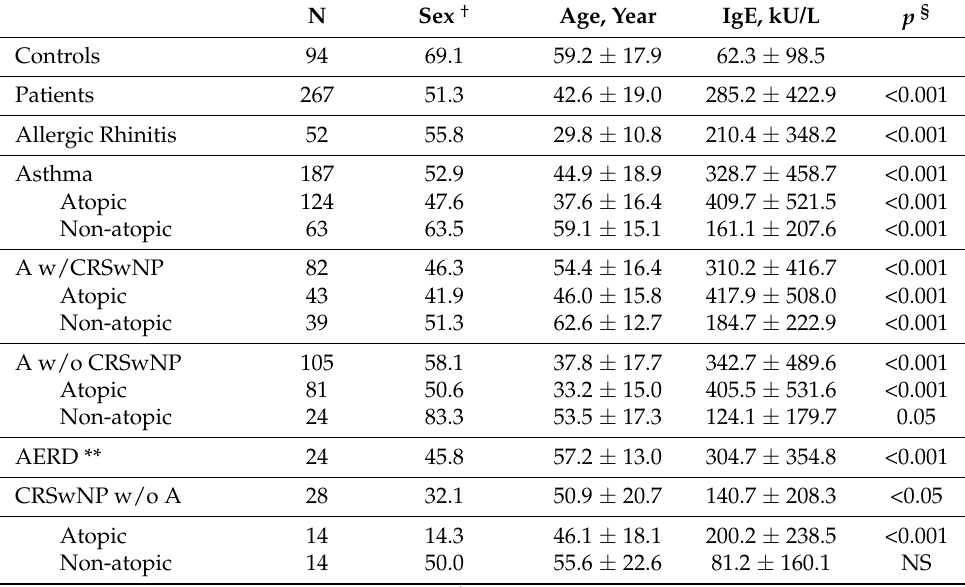
Table 4. Phenotypic characteristics of the population in the validation study.